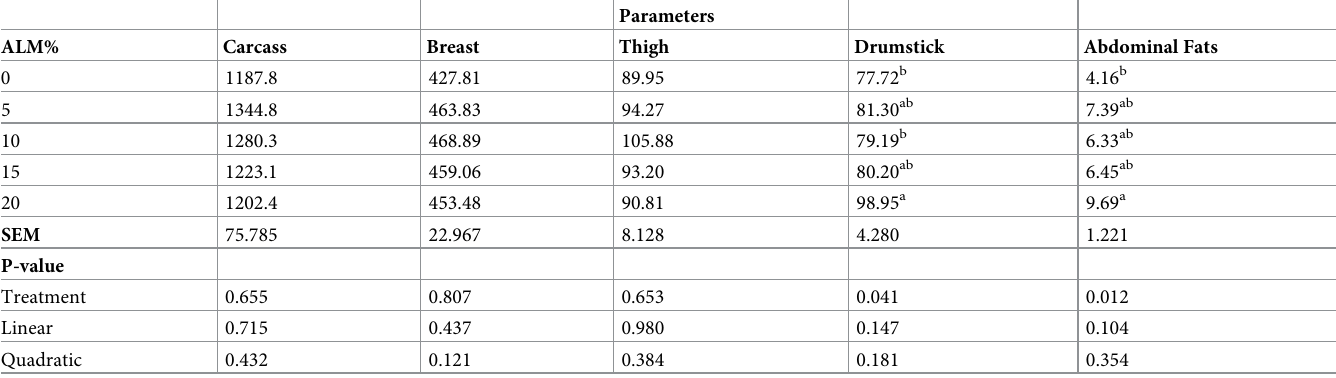
Table 5. Effect of amaranth leaf meal inclusion on carcass meat part weights (g) of Ross 308 broiler chickens.